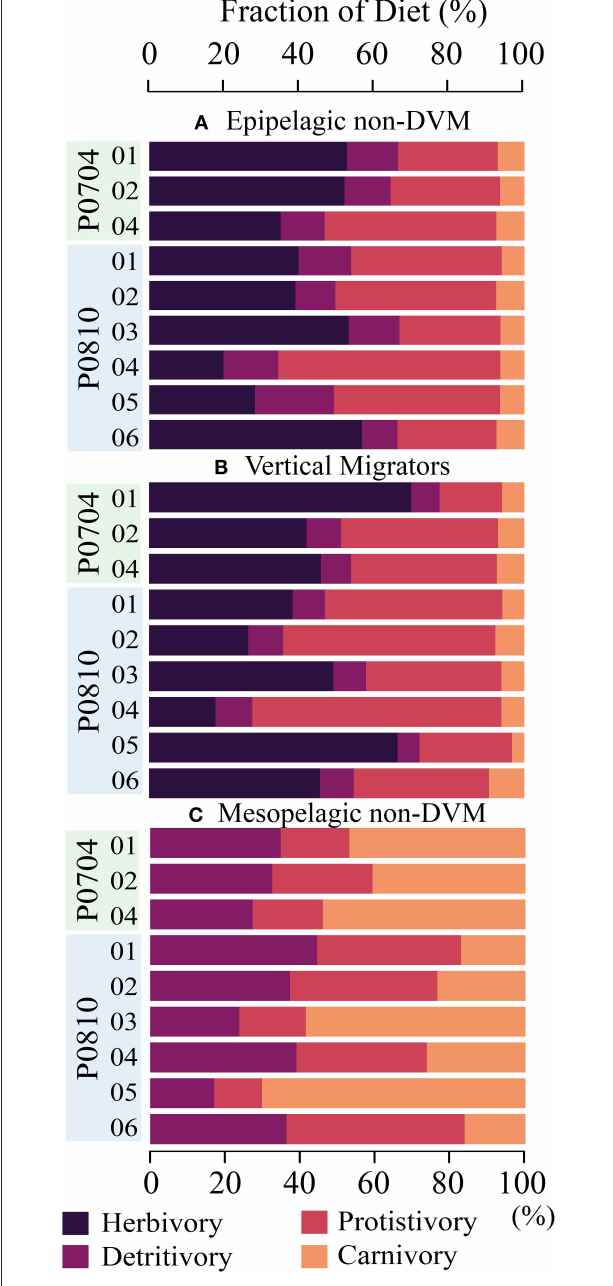
FIGURE 5 | Composition of diet for (A) epipelagic, non-DVM mesozooplankton, (B) vertically migrating mesozooplankton, and (C) mesopelagic, non-DVM mesozooplankton. Diet is partitioned into herbivory (darkest), protistivory, detritivory, and carnivory (lightest). Cycles are as indicated.